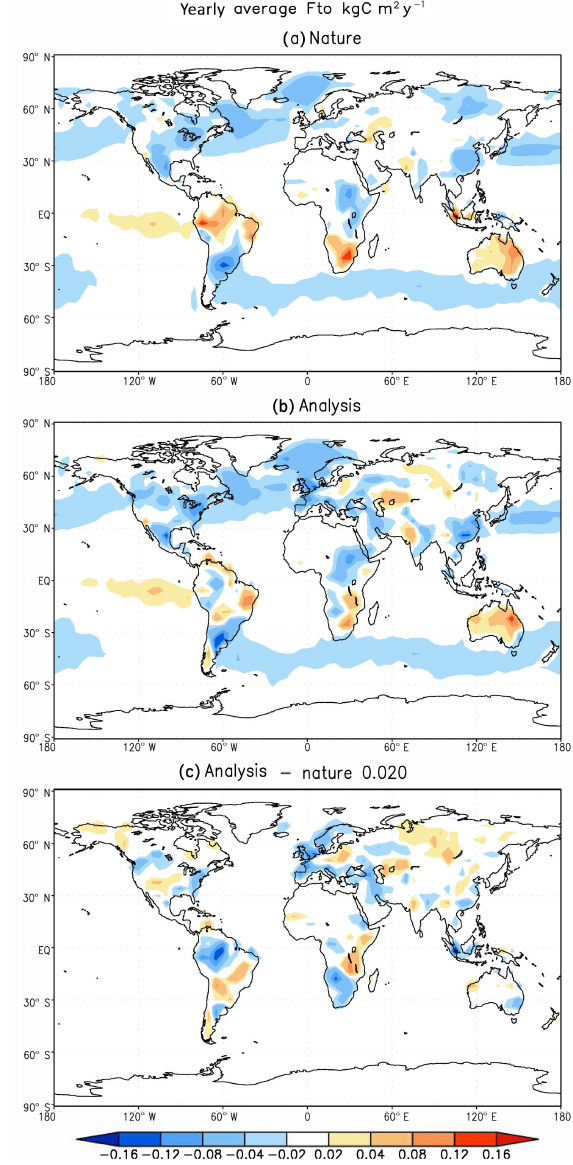
Figure 9. (a) The annual mean of SCF (with the F fe removed) for the “nature” run, (b) the annual mean of estimated SCF (with the F fe removed) from the benchmark experiment, and (c) their